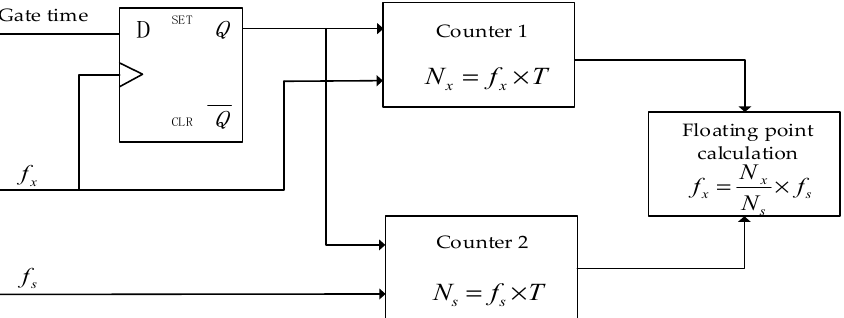
Figure 6 . Architecture of the equal-precision frequency measurement method. Figure 6. Architecture of the equal-precision frequency measurement